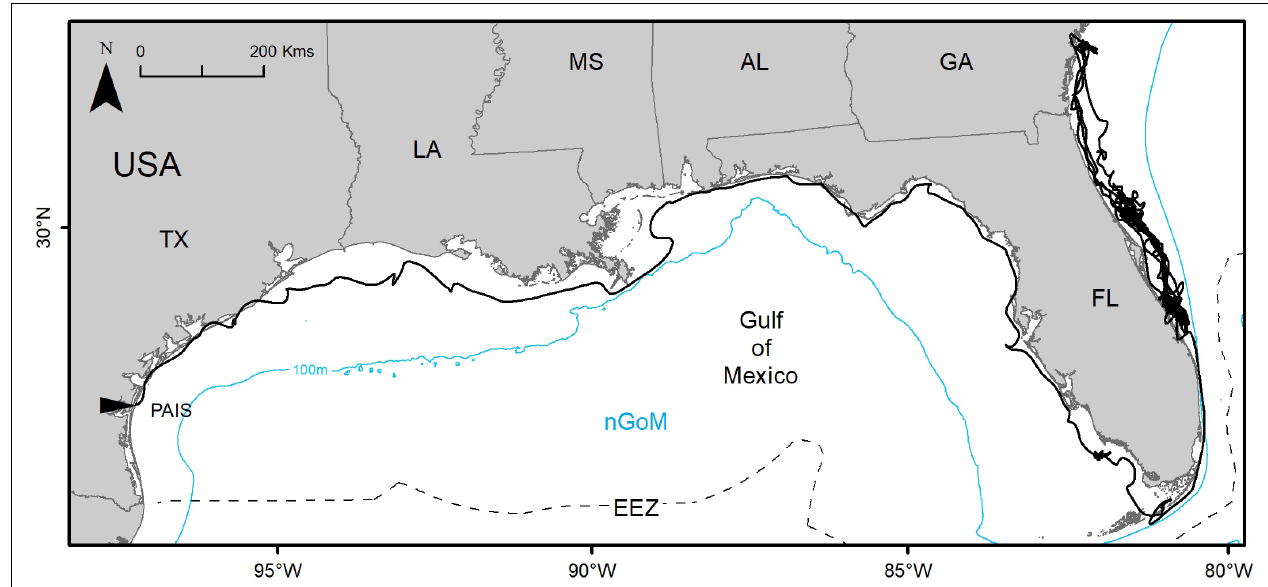
FIGURE 4 | Switching state-space model-derived track of PTT 152808 tracked between 02 July 2016 and 24 March 2019 (995 days) from Padre Island National Seashore, Texas, United States (PAIS) to the Atlantic coasts of Florida and Georgia, United States. The Exclusive Economic Zone (EEZ) demarcates the division between the northern Gulf of Mexico (nGoM) and southern Gulf of